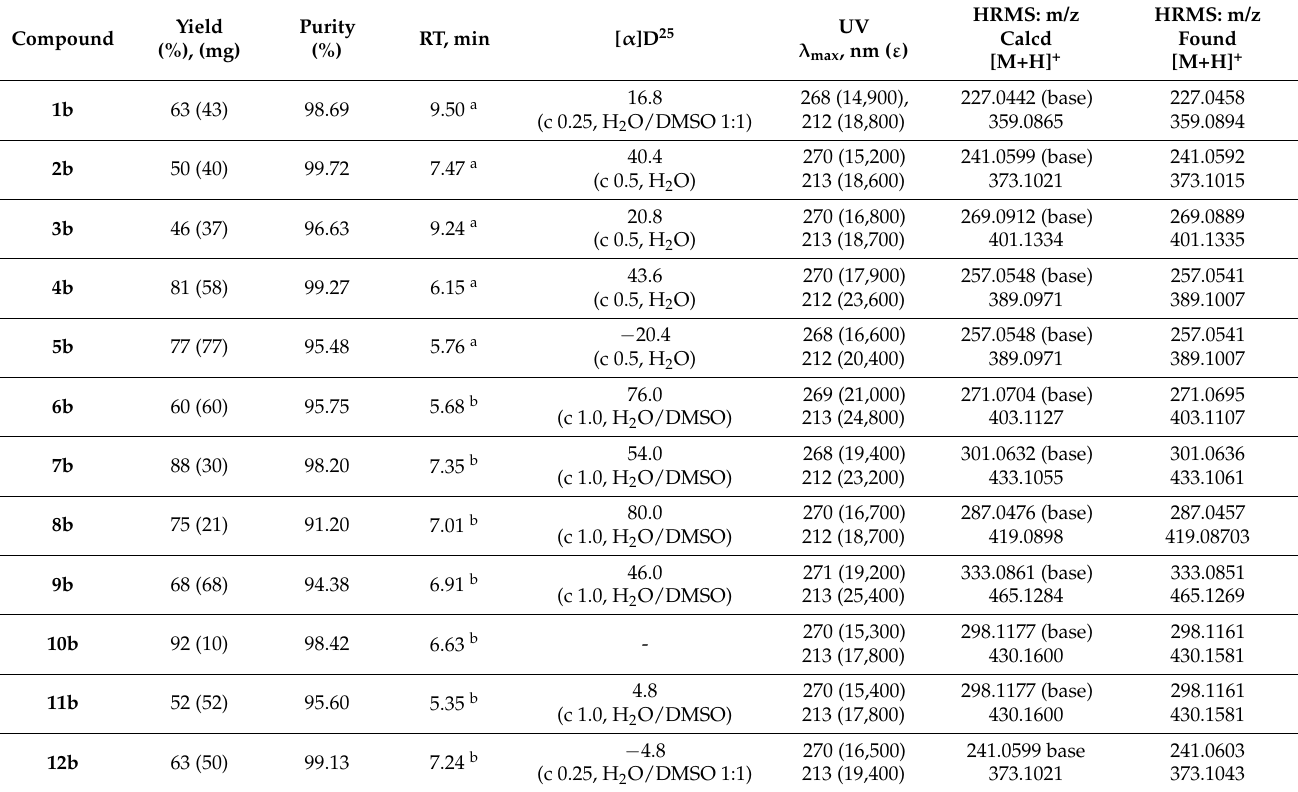
Table 4. Physicochemical properties of arabinonucleosides 1b–12b